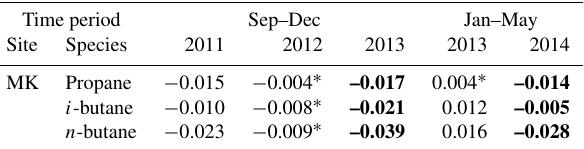
Table 4. Changing rates of propane and n/i -butanes in September– December and January–May in different years (ppbvday − 1